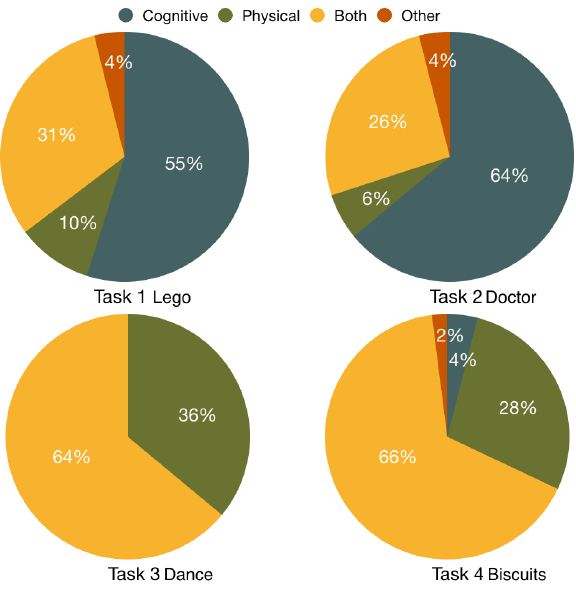
Figure 20: Classification of tasks according to their type.